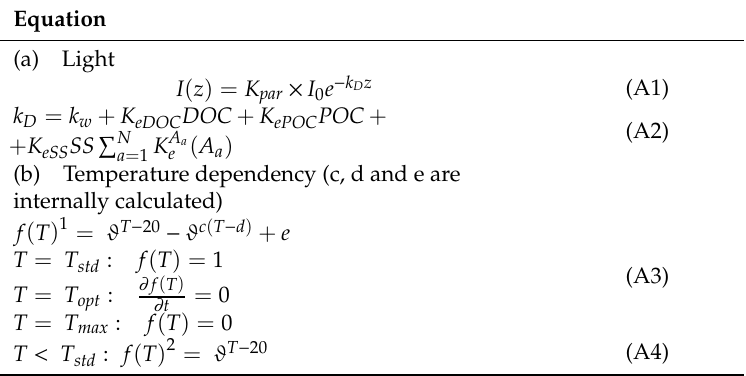
Table A2. Generic parameterizations of processes modelled in CAEDYM. Equations for light and water temperature dependency. a is related to phytoplankton group.